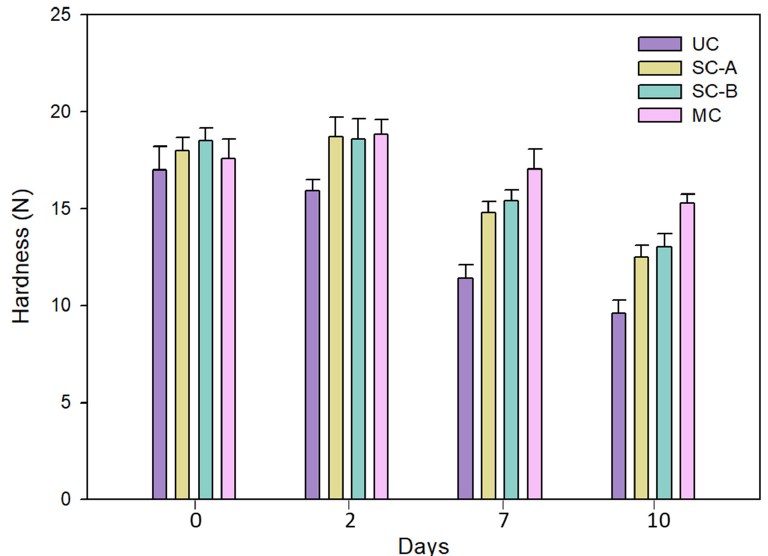
Figure 1. Hardness values for uncoated sample and for single-layer and multilayer coating treatment. N = 3; data shown are mean ± standard deviation.